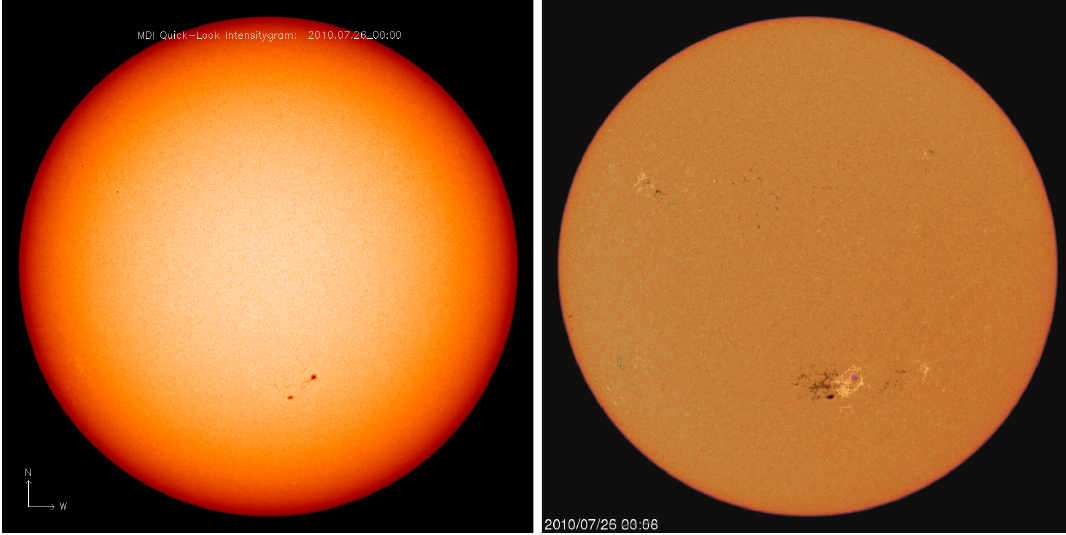
Figure 1: Still from a movie – SOHO/MDI white-light and magnetogram images taken on 26 July 2010 show that bipolar magnetic fields (white/black = positive/negative) are more extended than the sunspots that are seen in white-light images. Sunspots correspond to the strongest magnetic field concentrations in the magnetogram. However, the active region (AR) extends as far as the distinguishable magnetic field. (To watch the movie, please go to the online version of this review article at http://www.livingreviews. org/lrsp-2015-1